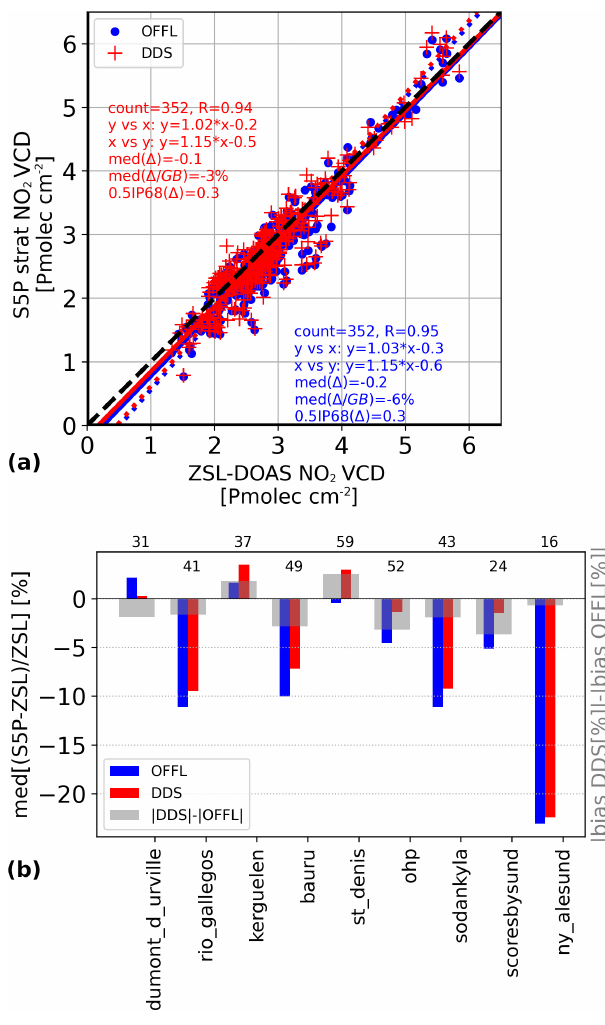
Figure 15. (a) Correlation between S5P/TROPOMI and ZSL- DOAS stratospheric NO 2 column number densities, after photo- chemical adjustment of the latter to the satellite overpass time. The operational OFFL data are presented in blue, the reprocessed DDS in red. Ordinary linear regression results are indicated for both y vs. x (solid lines) and x vs. y (dotted lines). IP68 is the central 68 interpercentile range, the difference between the 84th and 16th percentiles, a measure for the dispersion. (cid:49) is the difference “S5P minus GB”, where “GB” stands for ground-based. (b) Median rel- ative difference (bias) between S5P/TROPOMI and ZSL-DOAS stratospheric NO 2 column number densities, per station, for both the DDS data (red) and the corresponding OFFL data (blue). The change in the median relative difference is indicated in grey. The number of co-located pairs at each station is provided along the top axis. Stations are ordered per increasing latitude.